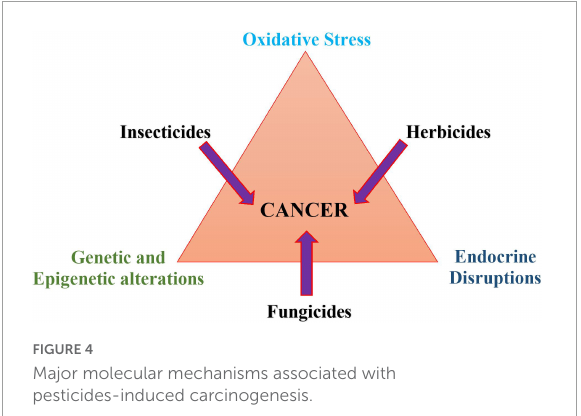
FIGURE4 Major molecular mechanisms associated with pesticides-induced